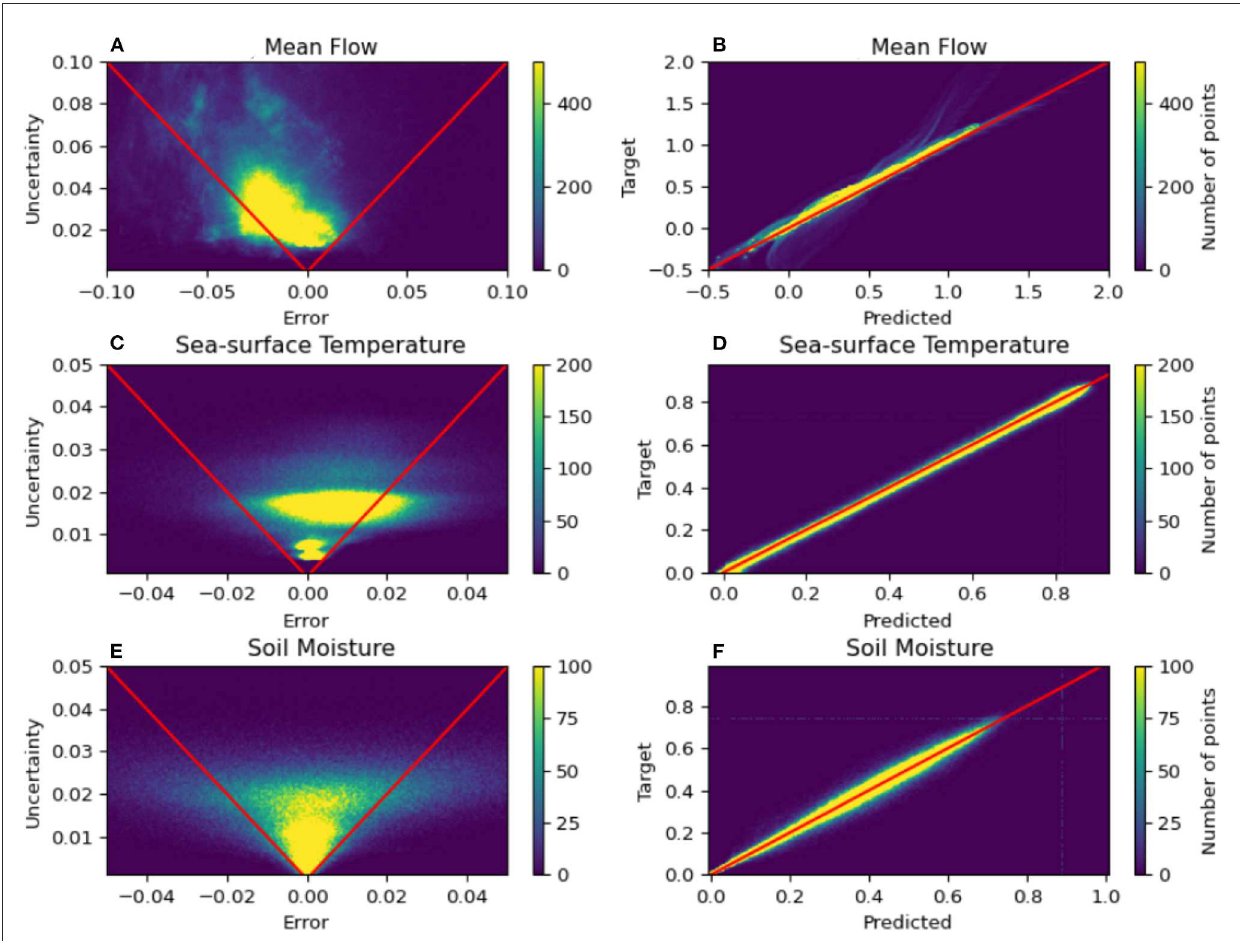
FIGURE3 Summary of the relationship between the epistemic uncertainty and the prediction error for the mean flow (A, B) , sea-surface temperature (C, D) , and soil moisture (E, F) examples. Figures in the left column show the correlation between the prediction error and the estimated uncertainty for each of the examples while the figures in the right column show the correlation between the predicted and the true target values for the same example. The areas of the figures in the left column that fall within the red cone contain the points in the super-resolved fields where the uncertainty estimate bounds the prediction error. The red lines in the right column signify the points where the predicted and the target values